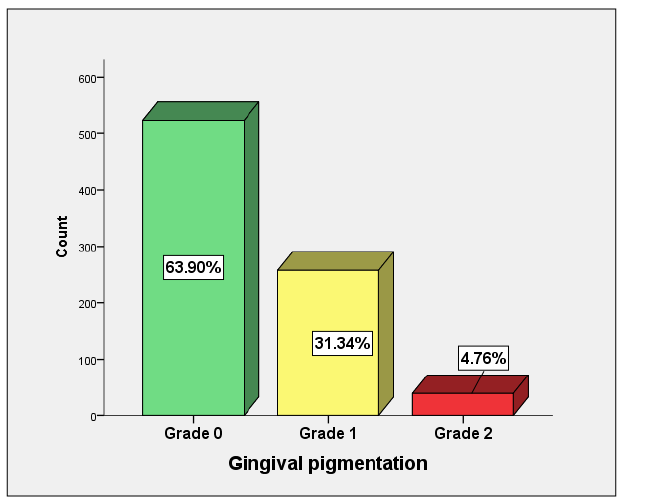
Figure. 1: Gingival Pigmentation among participants Regarding distribution of pigmentation, the majority (63.9%) of participants had no distribution of pigmentation, while in the remainder it was distributed in the marginal or attached gingiva and interdental papilla, as shown in Figure (2).